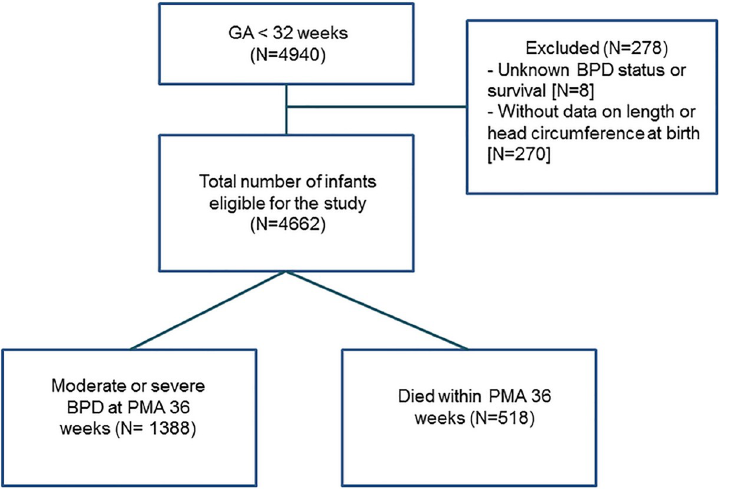
Fig 1. Flow diagram for the study